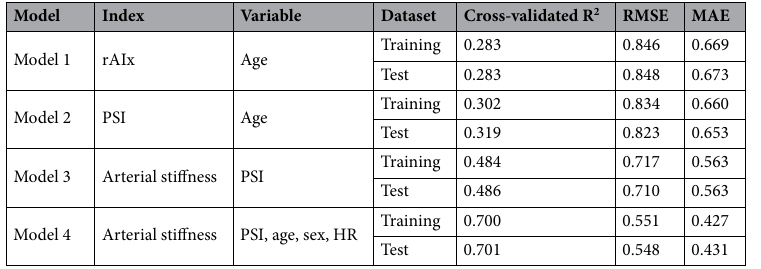
Table 3. Evaluation of the performance of the simple linear regression models and a MLR model based on tenfold